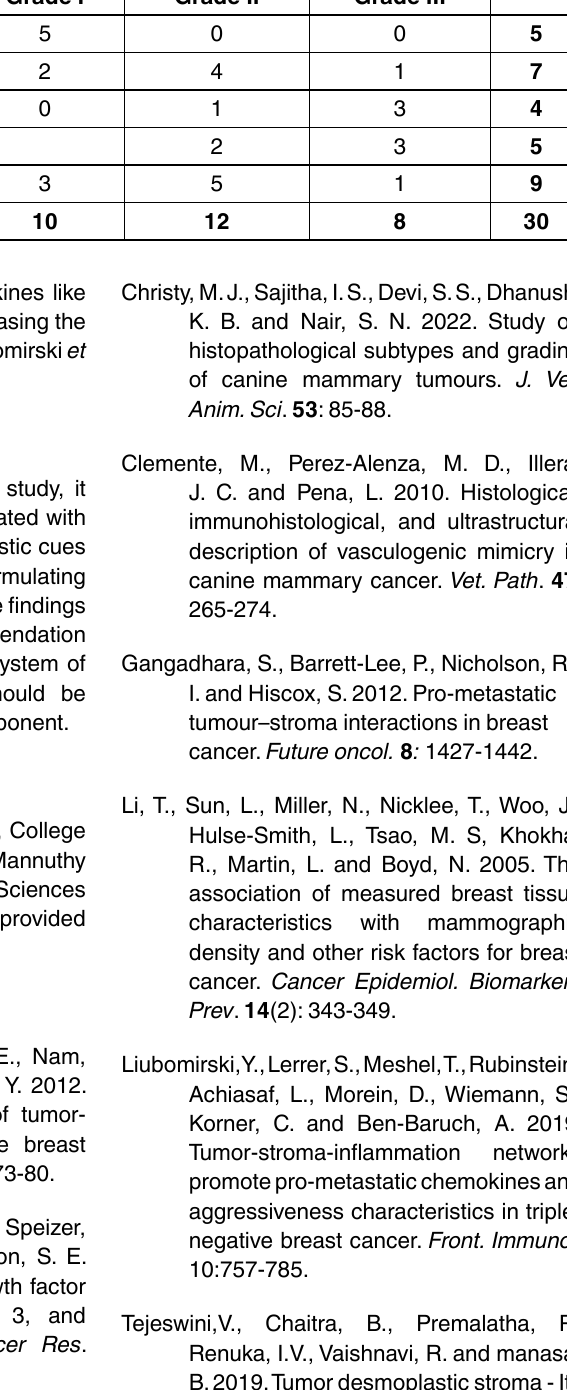
No. of cases histological histological histological Grade i Grade ii Grade iii